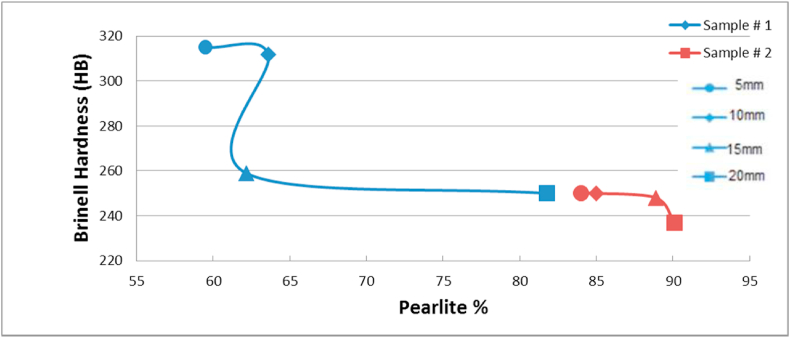
Pearlite% vs. hardness for sample #1 and sample # 2.